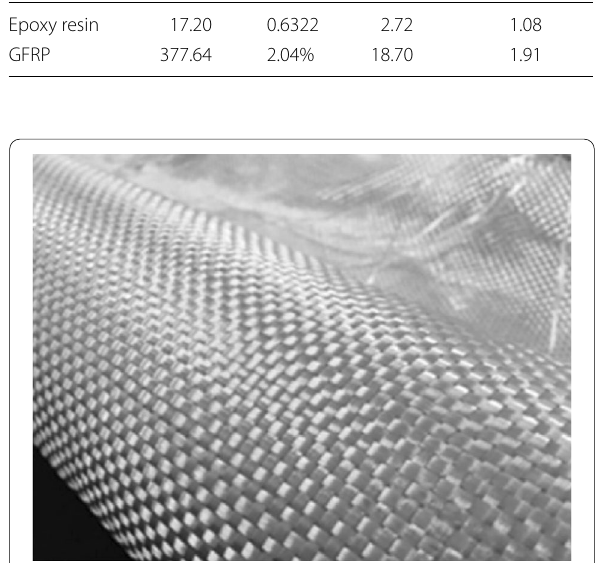
Fig. 2 Bi-directional glass fiber.